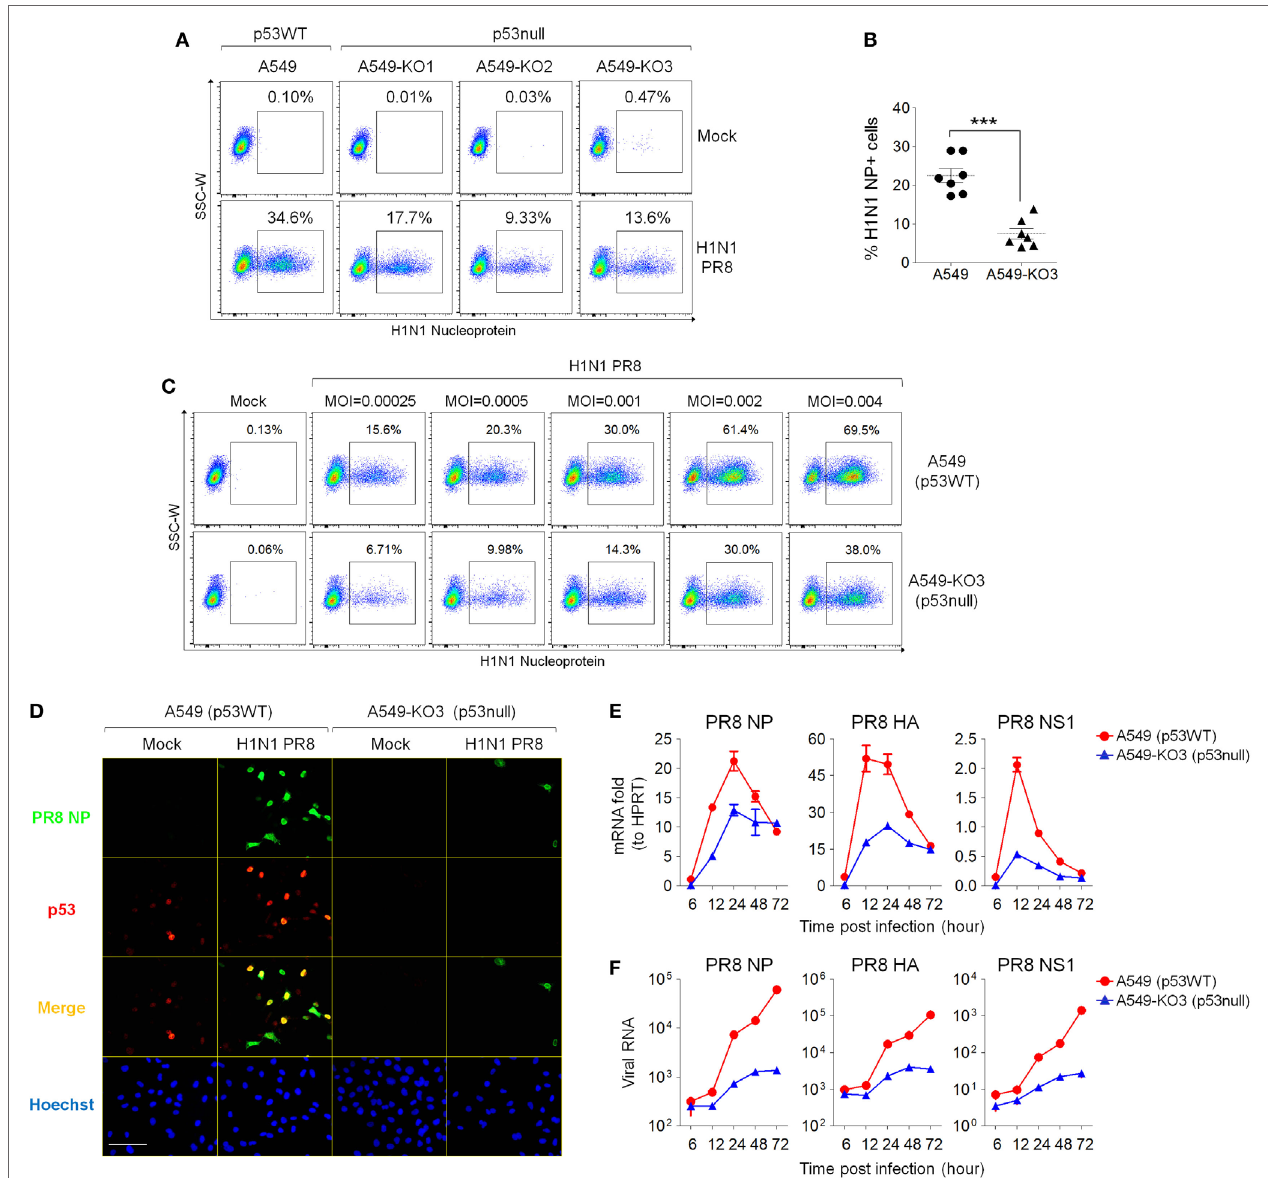
FigUre 2 | p53null A549 cells exhibit decreased influenza virus susceptibility compared with parental p53WT A549 cells. (a) p53null cells A549-KO1, A549-KO2, and A549-KO3 and p53WT A549 were infected with human influenza virus (IAV) (strain A/Puerto Rico/8/1934 H1N1), 24 h later, cells were fixed, permeabilized, and labeled for influenza nucleoprotein (NP) detection by flow cytometry. The population of NP-positive cells was gated, and their percentages are shown. (B) Percentages of NP-positive cells 24 h post-IAV infection were compared between A549 and A549-KO3 cells from seven individual experiments. *** p < 0.001. (c) Flow cytometry analysis of NP-positive p53WT A549 and A549-KO3 cells 24 h post-IAV infection at a range of multiplicity of infection (MOI). (D) Fluorescence imaging of A549 and A549-KO3 cells co-labeled for viral NP (green) and cellular p53 (red) 24 h post-IAV infection. Scale bar, 50 µm. (e) Real-time quantitative PCR (RT-qPCR) measurement of viral RNA encoding NP, hemagglutinin (HA), and non-structural protein 1 (NS1) in mock- and IAV-infected A549 and A549-KO3 cells at various time points. (F) RT-qPCR measurement of viral RNA encoding NP, HA, and NS1 in culture supernatants of IAV-infected A549 and A549-KO3 cells at various time